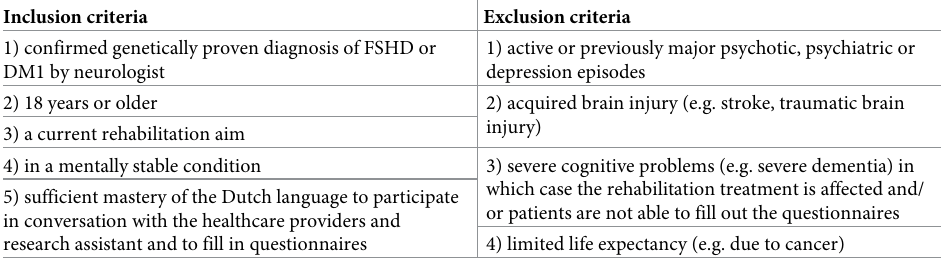
Table 1. Inclusion and exclusion criteria of the ReCap-NMD